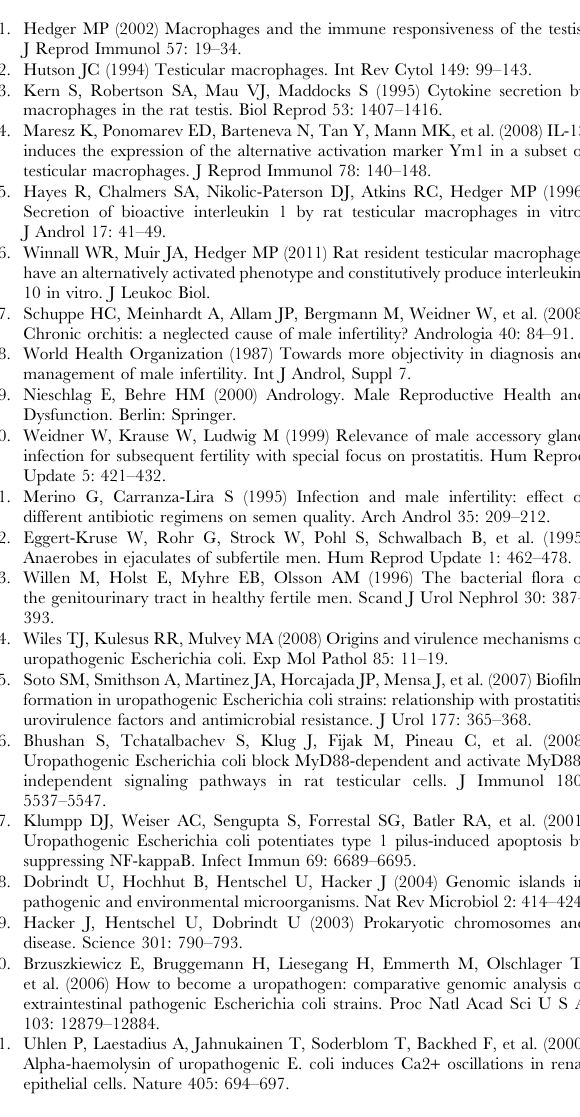
Figure S7 The MAP kinase JNK inhibitor SP600125 induces cell death in PM. (A) PM were treated with JNK inhibitor SP600125 at the indicated concentration for 24 h. Cell viability was determined using the colorimetric MTT assay. Results are presented as means 6 SD of triplicates. Mann- Whitney U test was used to analyze data. Values with different letters superscript differ significantly compared to control (Ctrl).